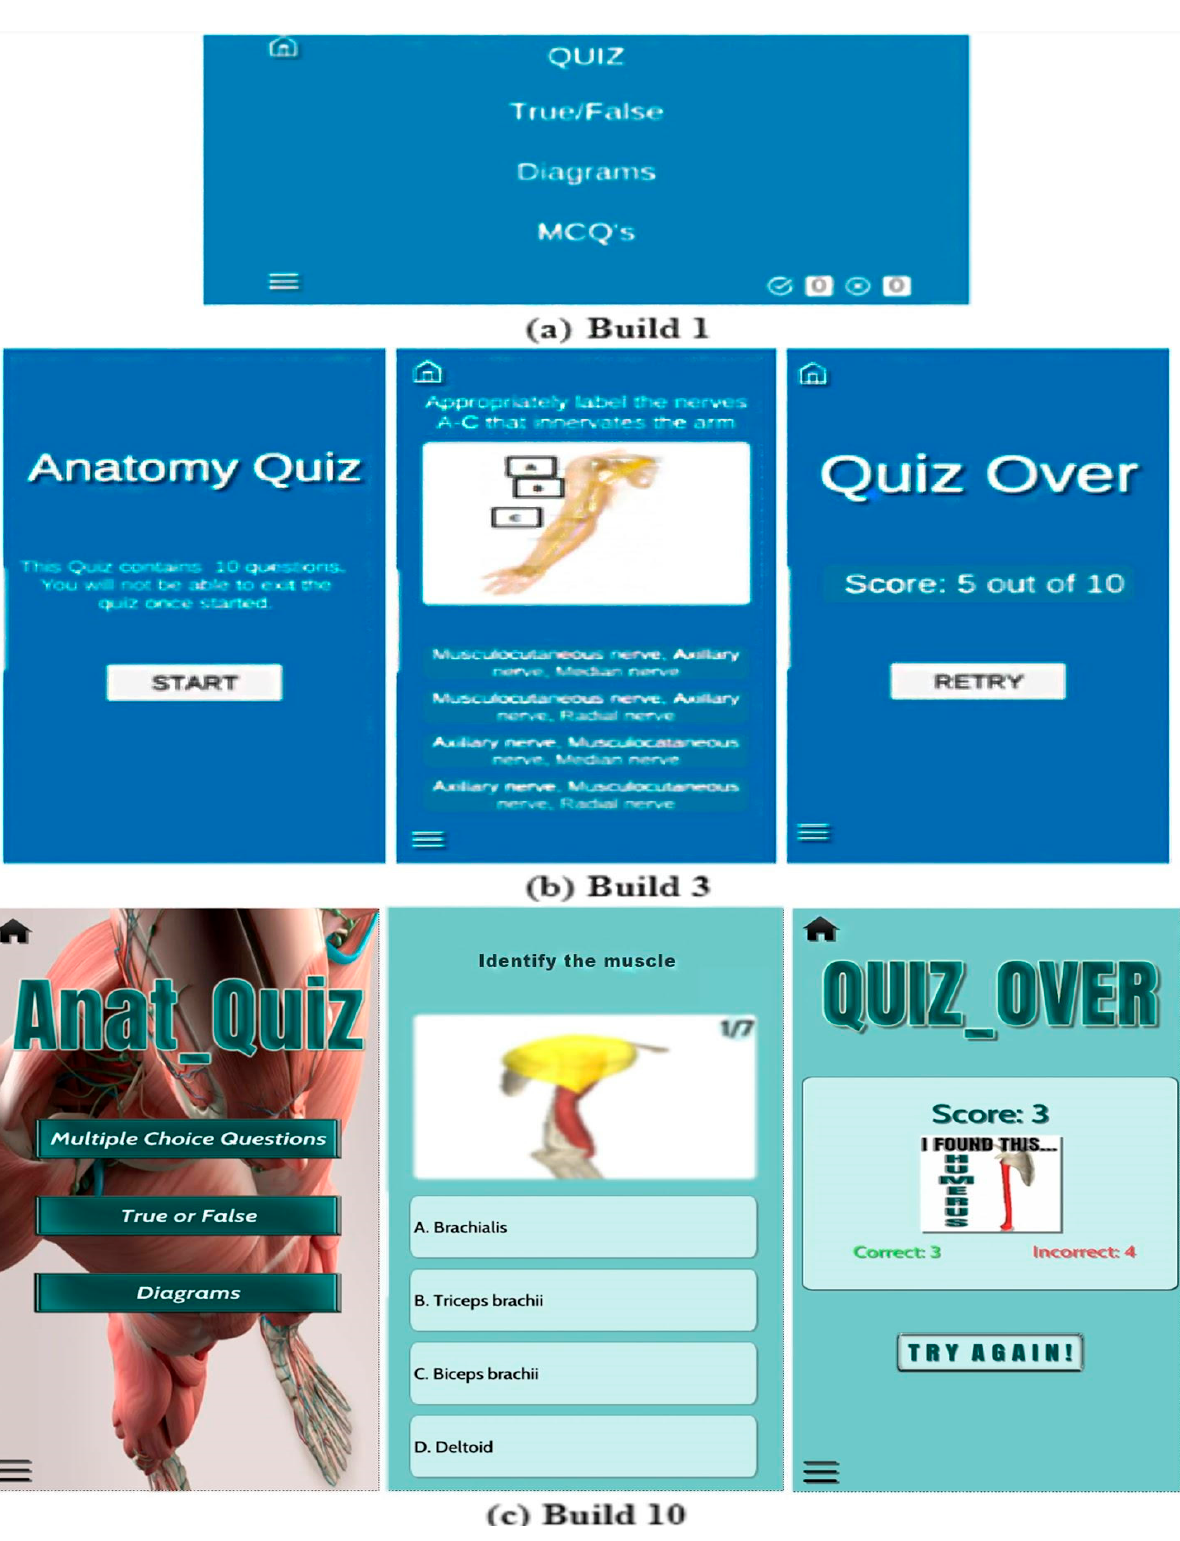
Figure 10. The changes made to the Quiz feature during application development.